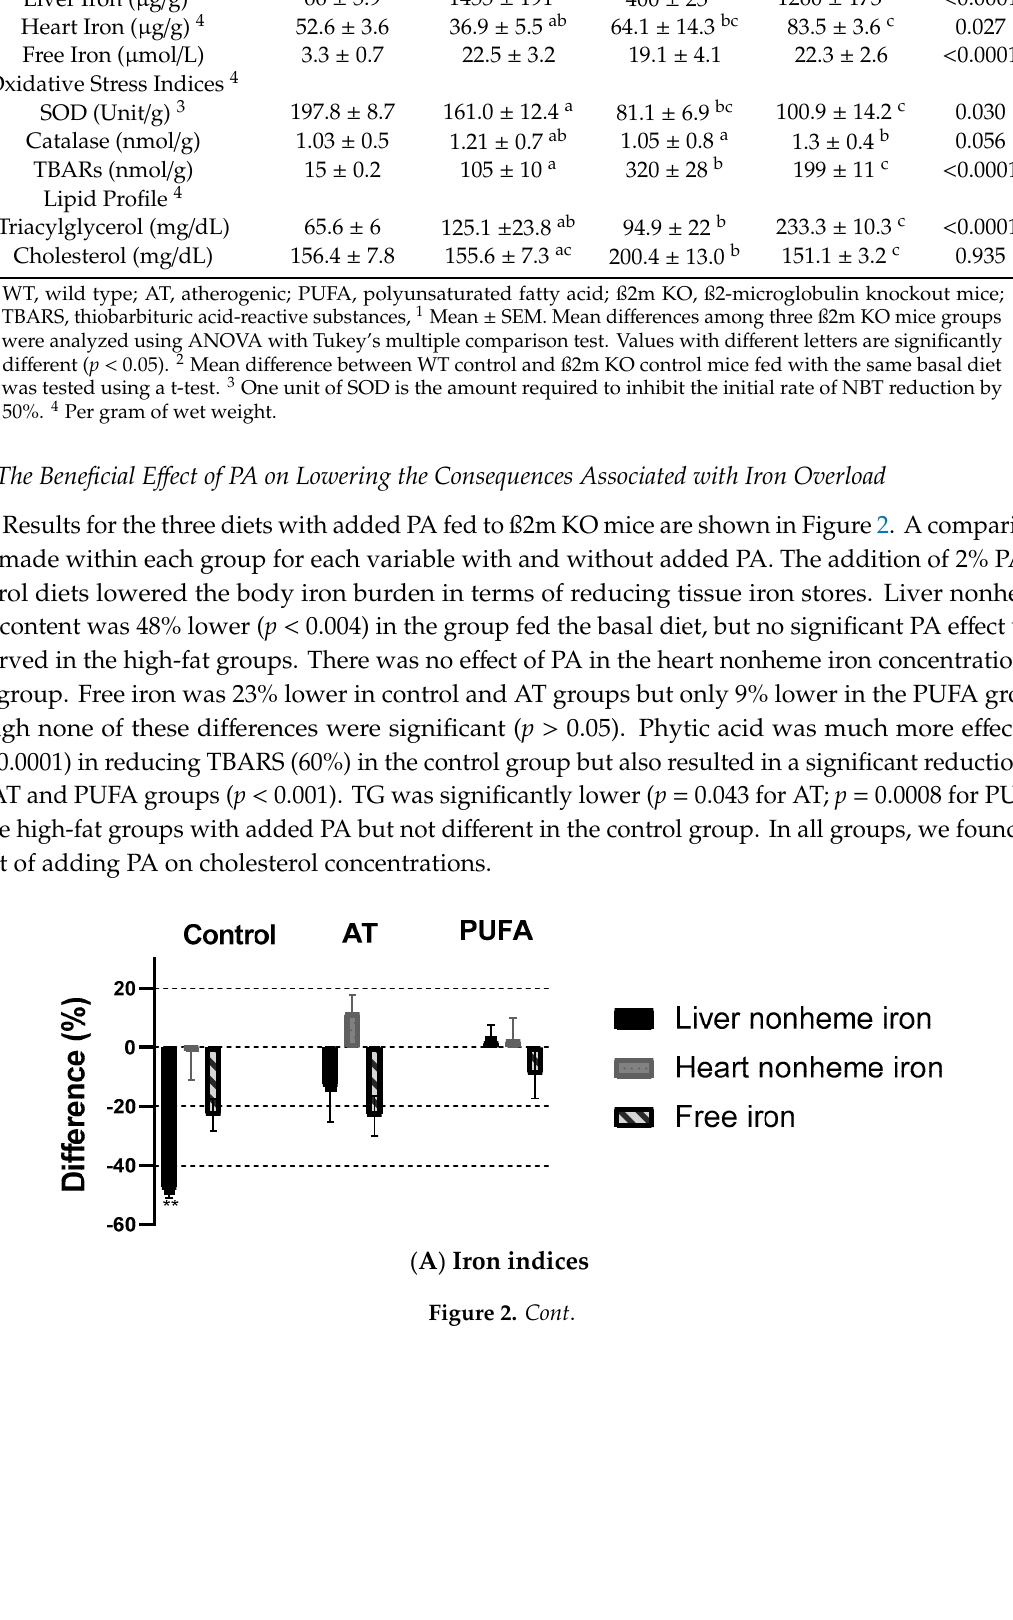
( B ) Oxidative stress markers (C) Serum lipids Figure 2. Effect of phytic acid on iron indices ( A ), oxidative stress indices ( B ), and serum lipids ( C ) fed in ß2m KO mice fed basal, AT, and PUFA diets with and without phytic acid. Each bar represents